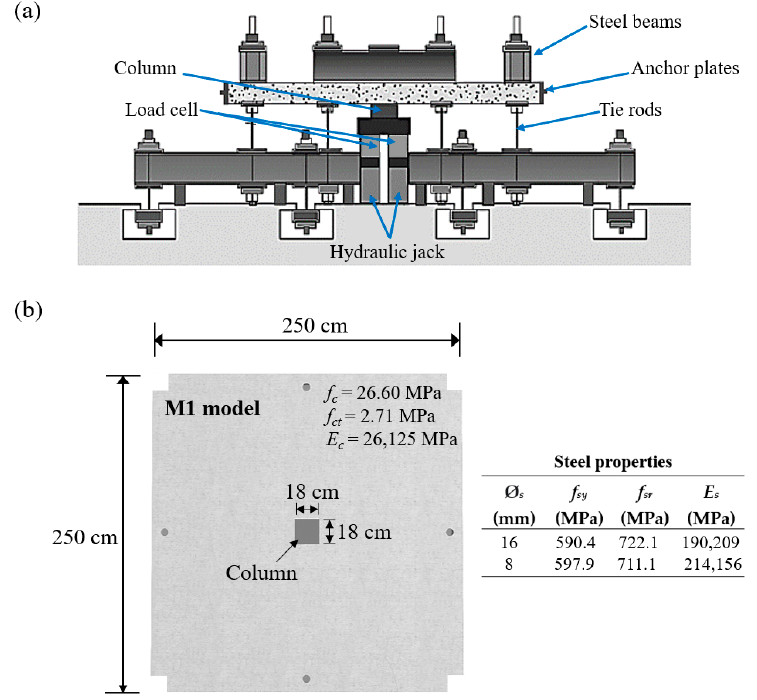
Figure 5. ( a ) Test setup, ( b ) M1 slab characteristics [1].